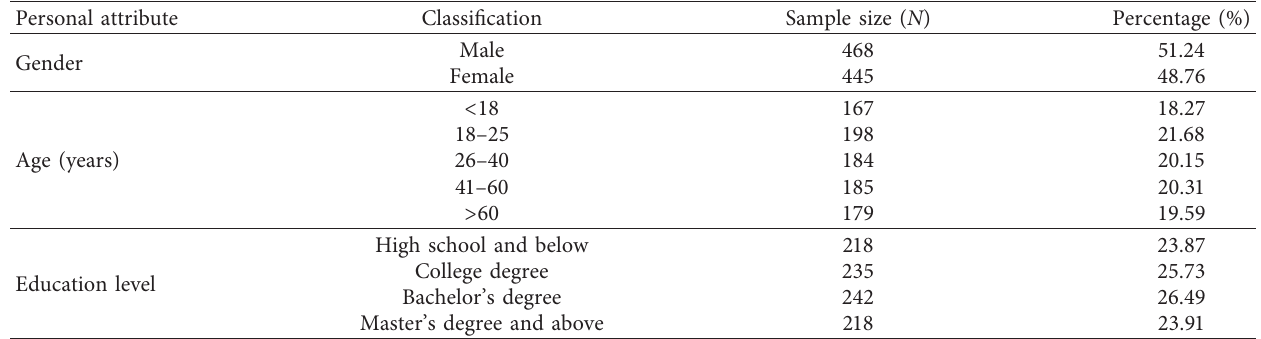
Table 2: Description of questionnaire statistics ( N � 913).